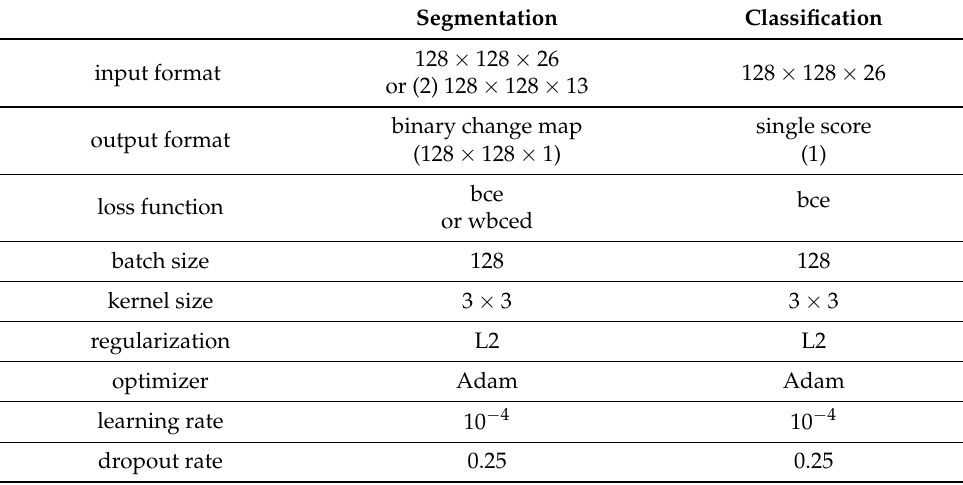
Table 2. Training details of the segmentation and classification